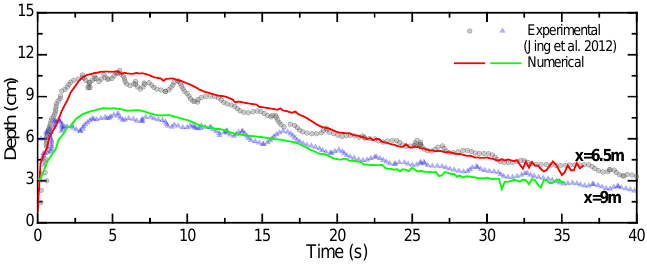
Figure 5. Comparison of slurry depth versus time at x = 6.5 m (from t = 1.6 s) and x = 9 m (from t = 3.8 s).